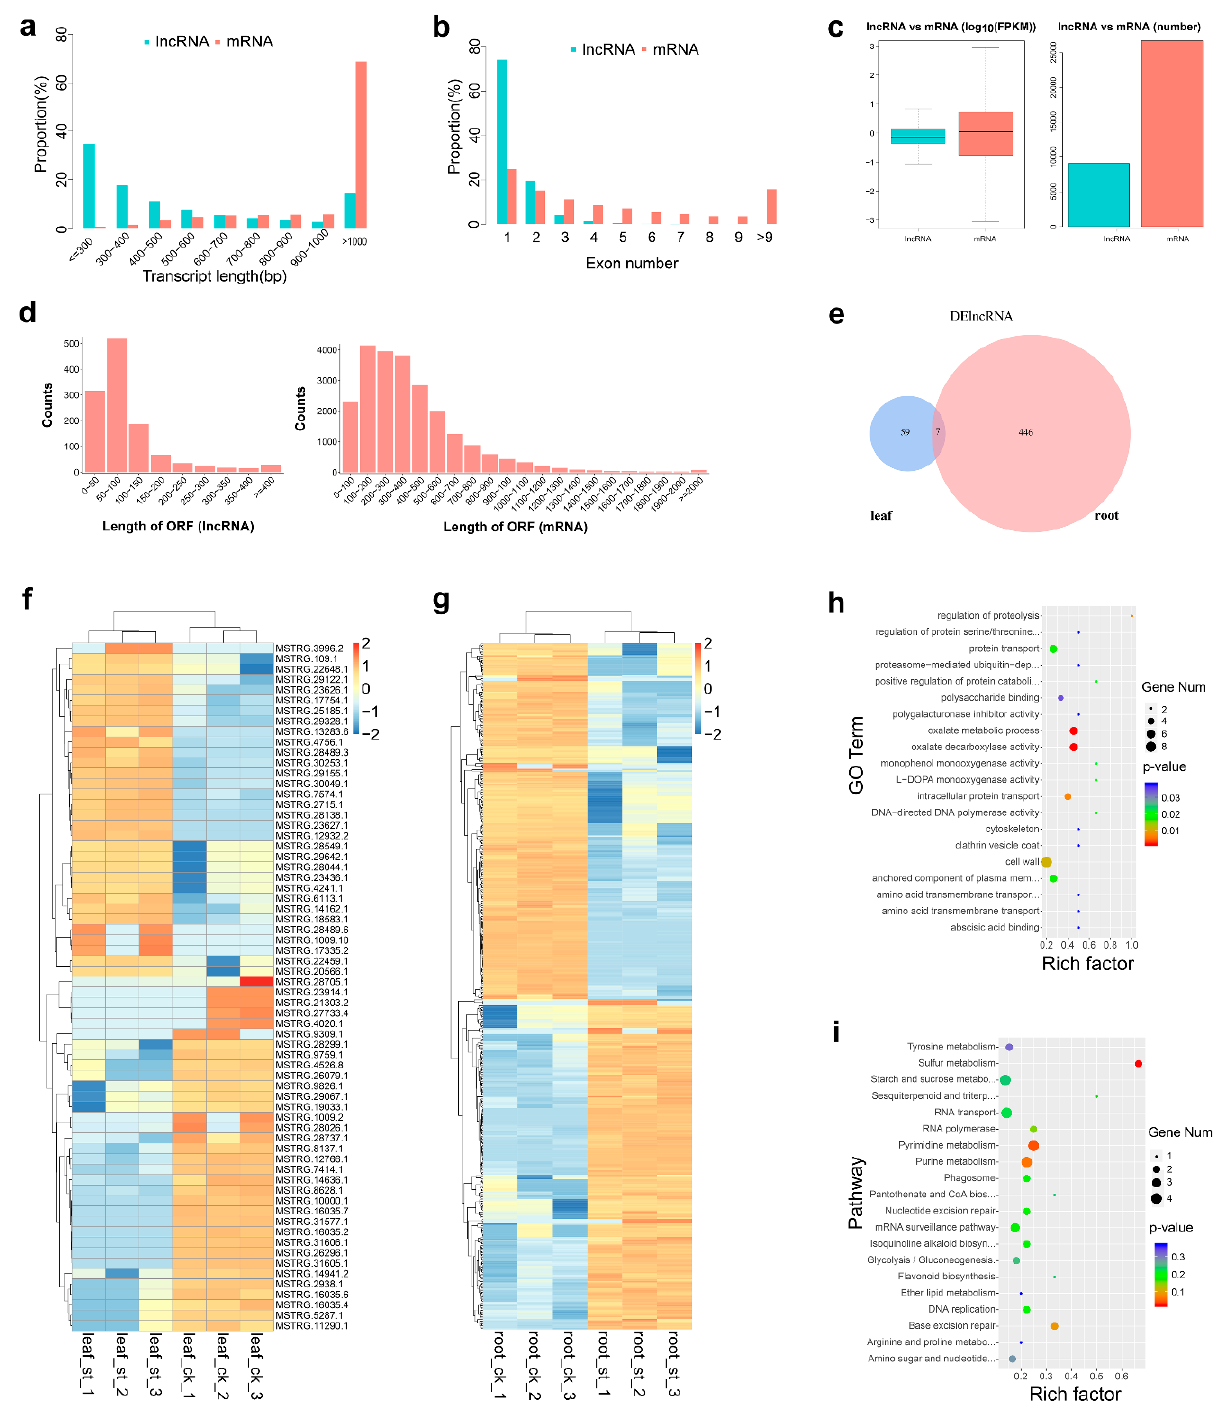
Figure 2. Identification and analysis of DElncRNAs under salt stress. ( a – d ) Comparison of transcript length, exon number, fragments per kilobase of transcript per million mapped reads (FPKM) value, numbers and ORF length in lncRNA versus mRNA. ( e ) Venn diagram of DElncRNAs in leaves and roots. ( f , g ) Heat map of DElncRNAs in leaves ( g ) and in roots. ( h ) GO enrichment of targets of DElncRNAs in roots; ( i ) KEGG enrichment of targets of roots DElncRNAs.